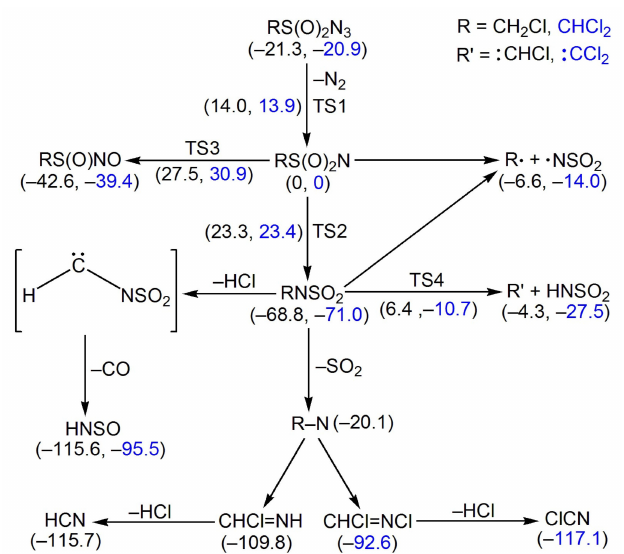
Figure 6. Calculated energy profile for the decomposition of RS(O) 2 N 3 (R = CH 2 Cl and CHCl 2 ) in the singlet state at the B3LYP/6-311++G(3df,3pd) level of theory. The calculated molecules structures (bond lengths in Å and angles in ◦ ) for the selected species are also